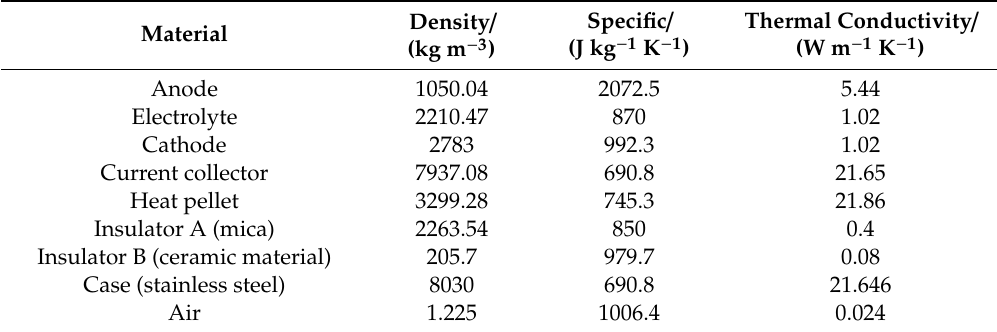
Table 1. Thermophysical parameters at 300 K